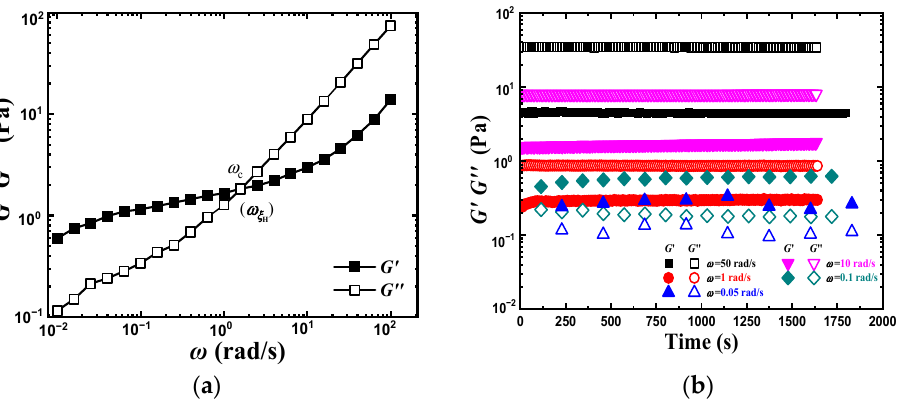
Figure 1. Dynamic rheological behavior of 10wt% PVA aqueous solution. ( a ) Frequency scanning result. ( b ) Timescanning result.